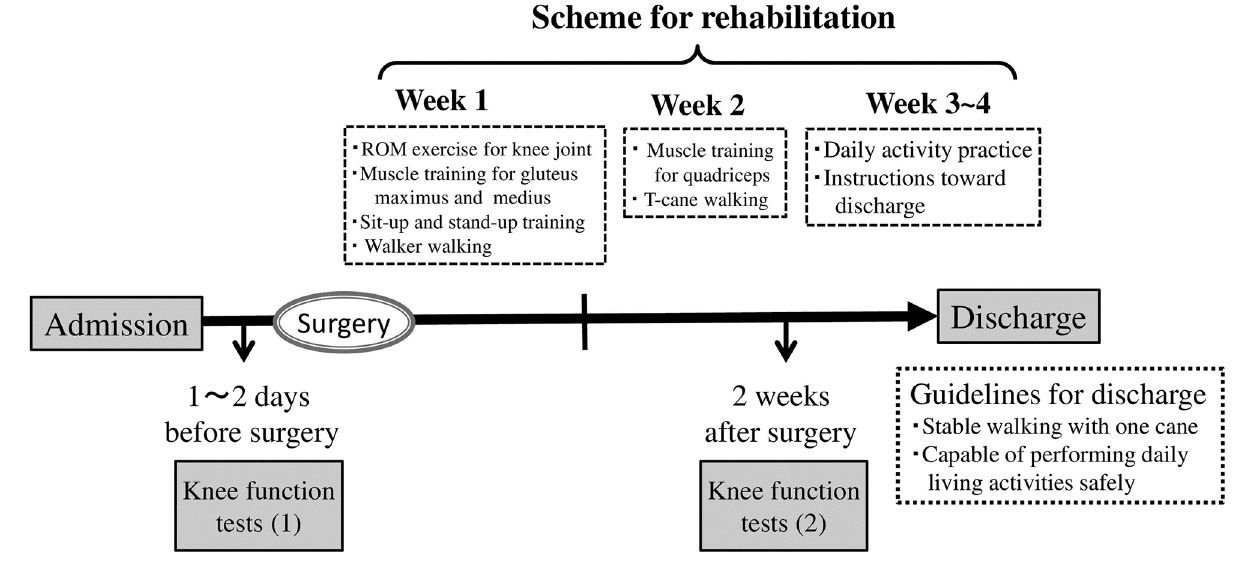
Fig 1. Clinical pathway for knee replacement